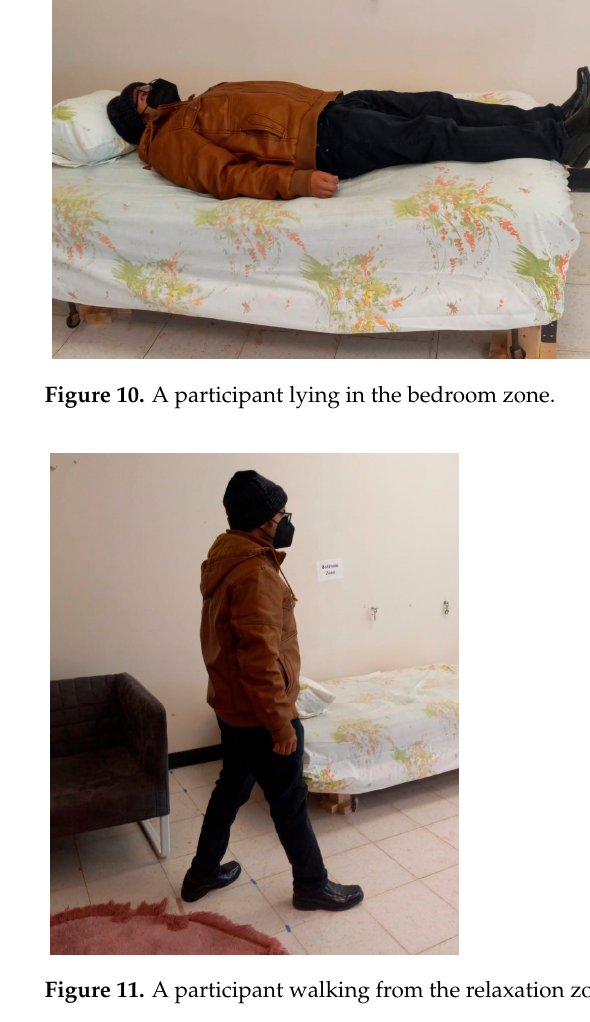
Figure 11. A participant walking from the relaxation zone to the bedroom zone.